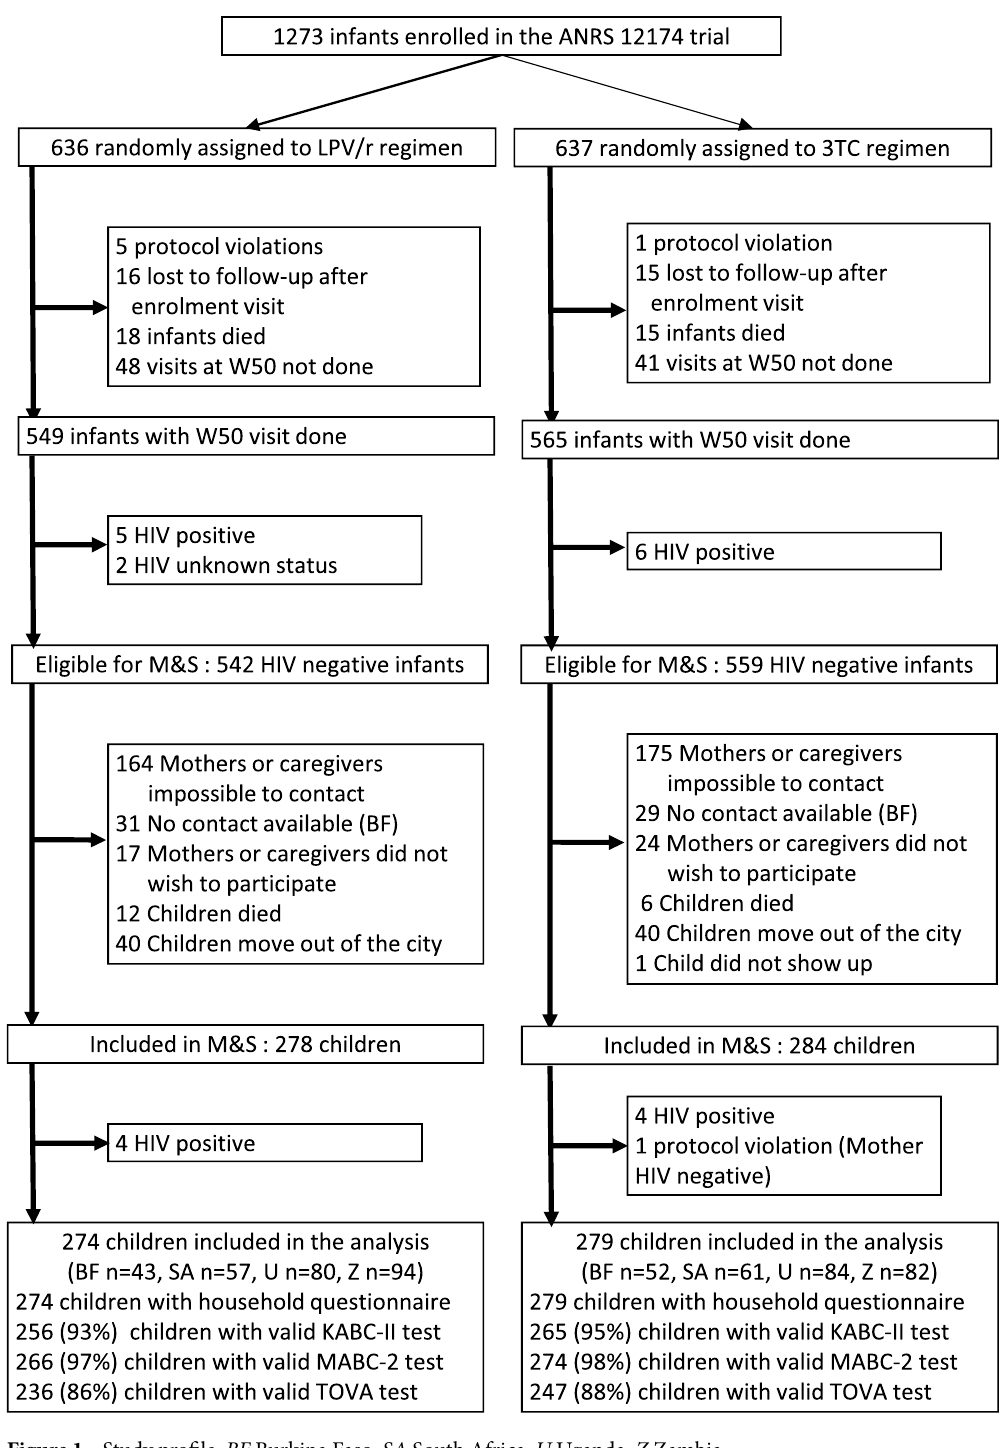
Figure 1. Study profile. BF Burkina Faso, SA South Africa, U Uganda, Z